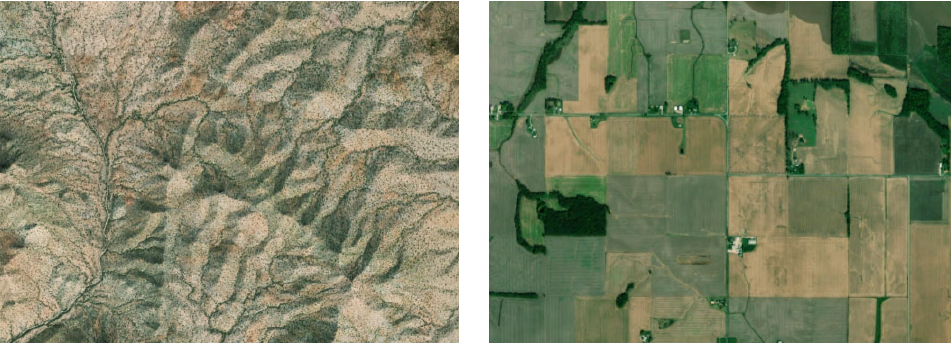
Figure 15. Typical “desert” (DS) and “farm” (FM) terrain